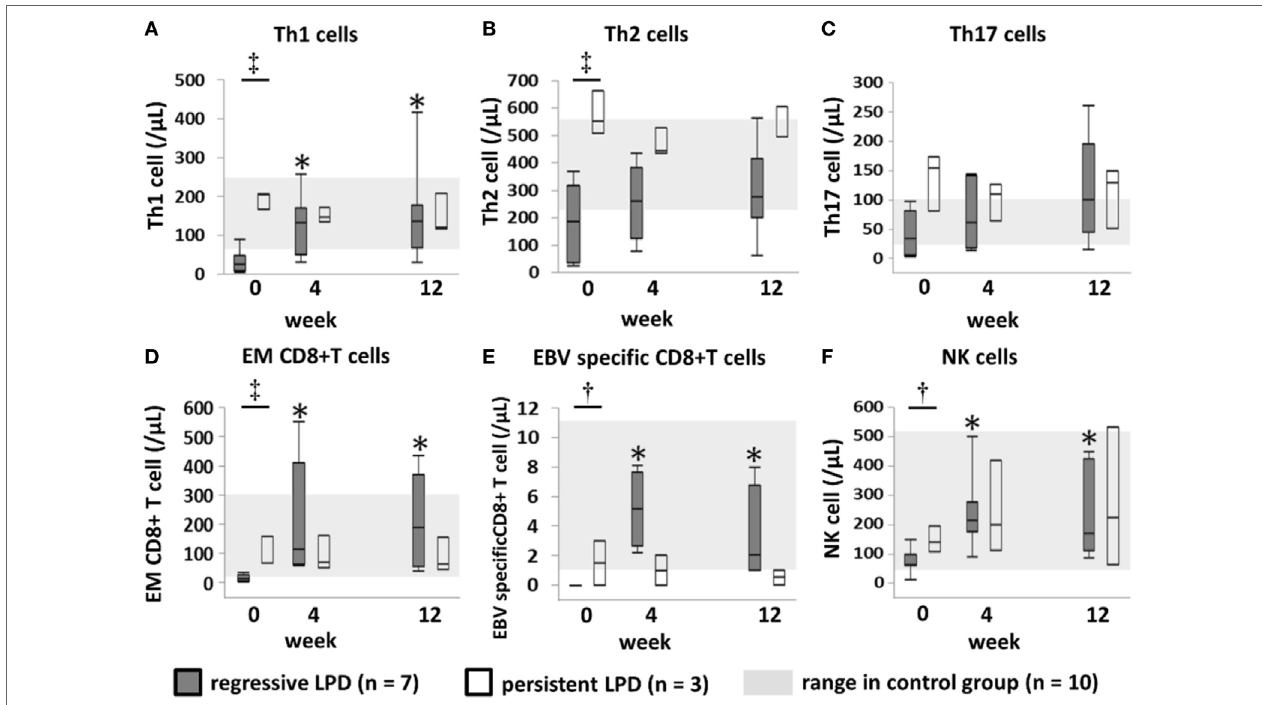
Figure 5 | Transition of absolute number of lymphocyte subsets. Transition of the absolute number of (a) Th1, (B) Th2, and (c) Th17 cells among CD4+ T cells; (D) EMCD8+ T cells and (e) EBV-specific CD8+ T cells among CD8+ T cells; and (F) NK cells among lymphocytes, after MTX cessation. Comparison between the three groups was conducted by Kruskal–Wallis test, and comparison between two groups was conducted by Wilcoxon test. † Regressive vs. Control, P < 0.05. ‡ Regressive vs. Control, P < 0.05; Regressive vs. Persistent, P < 0.05. * P < 0.05 for the comparison with the value at week 0 in each group. Th1/2/17, T helper 1/2/17; EM, effector memory; EBV, Epstein–Barr Virus; NK cell, natural killer cell.